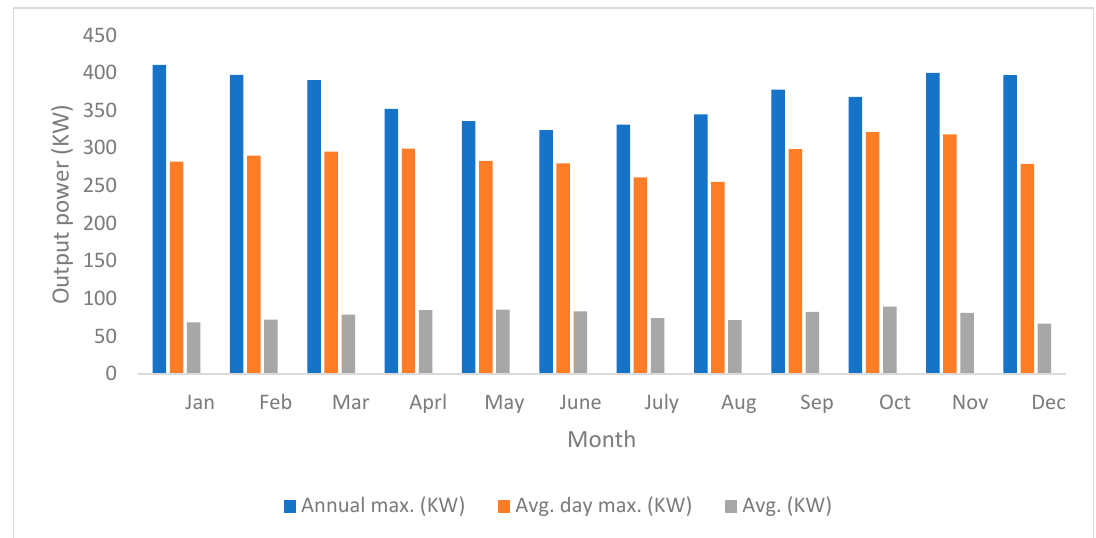
Figure 13. Monthly avg. total renewable power output (KW).